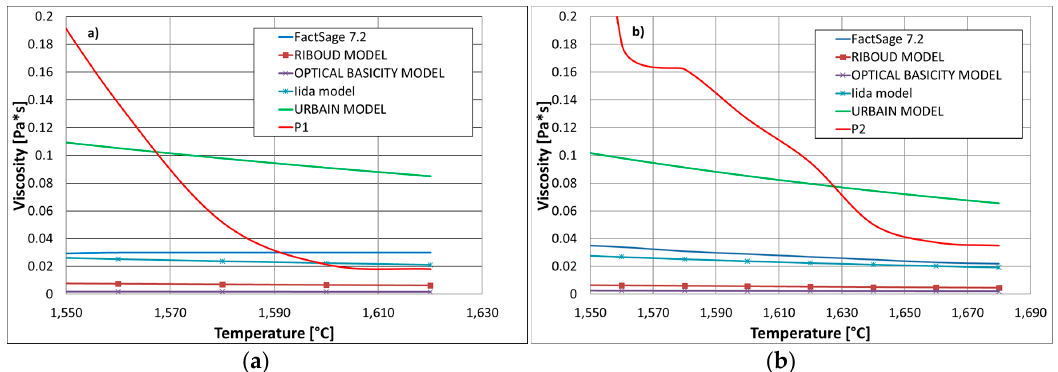
Table 4. Chemical composition (in mass%) of the reference slags from Figure 3.